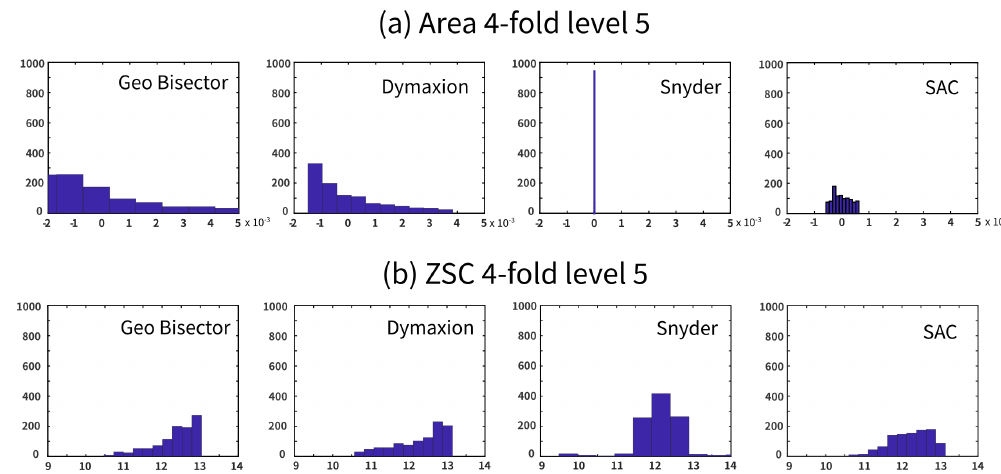
Figure 21. The distribution histograms of area and compactness for different methods. These values are for the tetrahedron partitions.